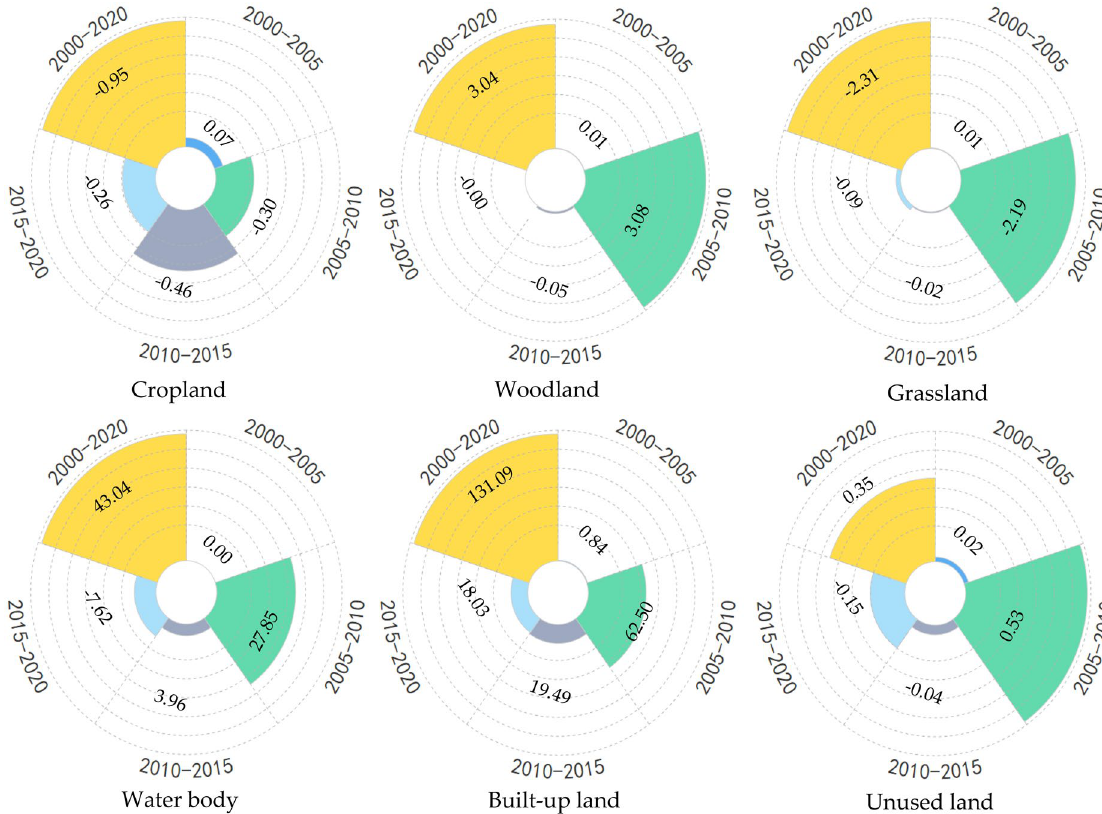
Figure 2. The change rate of carbon storage of different land use types in different periods (unit: